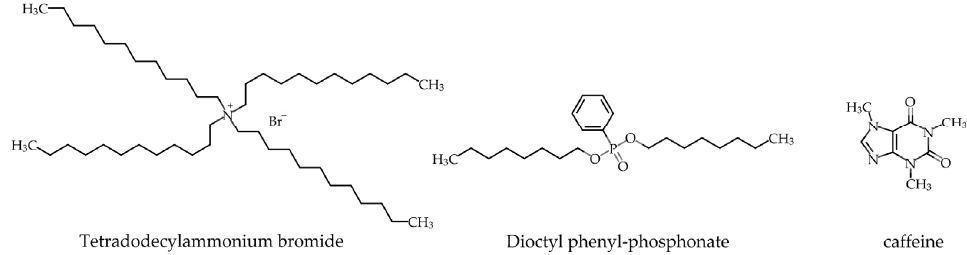
Figure 1. Molecular formulae of tetradodecylammonium bromide (TDAB), dioctyl phenyl-phosphonate (DOPP), and caffeine.